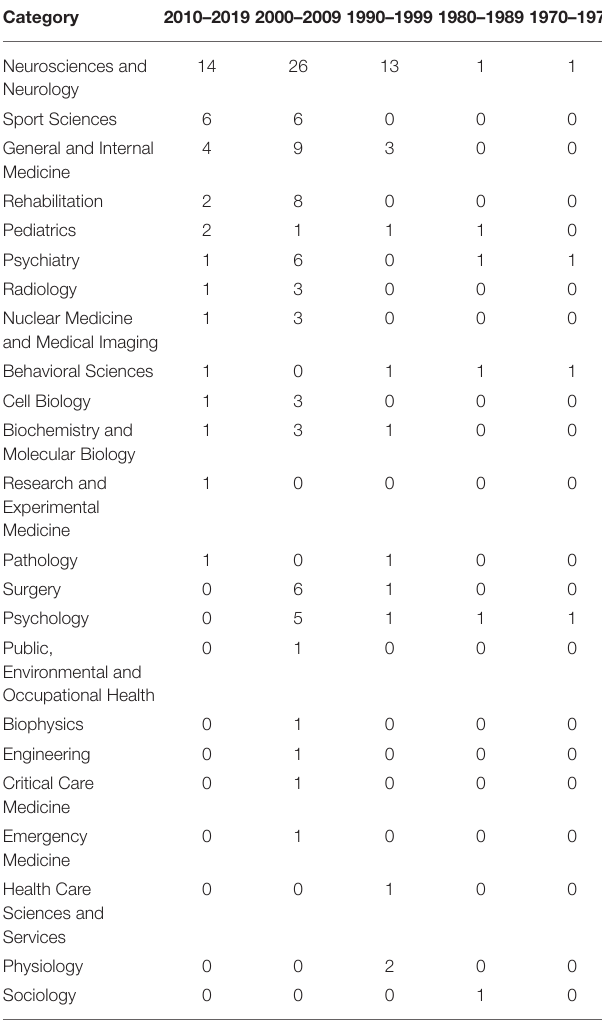
TABLE 7 | Article category of the top-100 cited